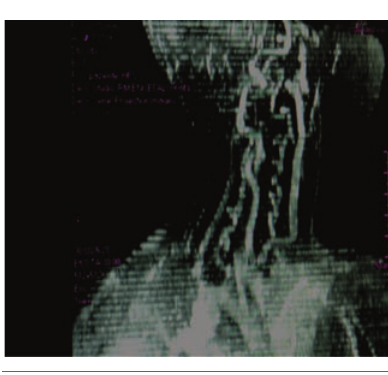
Figure 2. Angio-magnetic resonance demonstrating corkscrew tortuosity of arteries of neck and